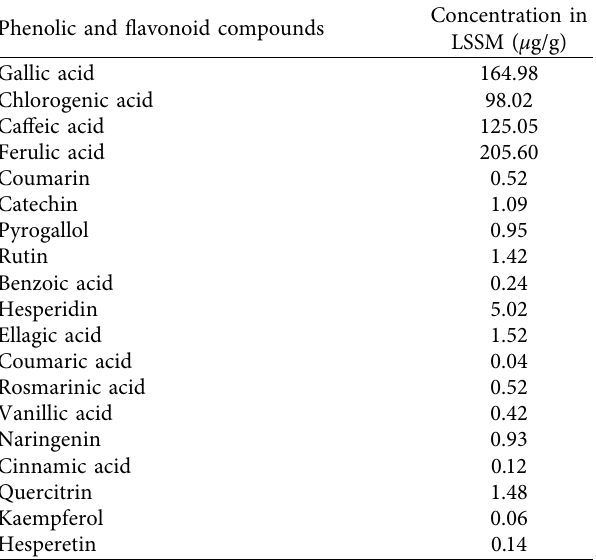
Table 1: The concentrations of phenolic and flavonoids ( µ g/g) in extracted Lepidium sativum seeds mucilage